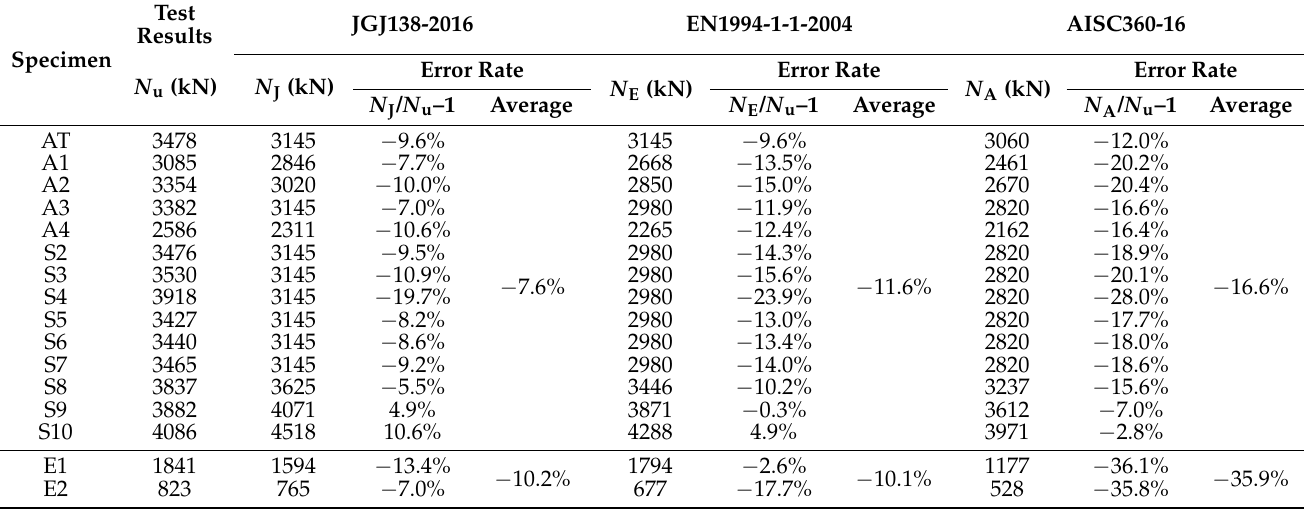
Figure 14. The simulation results at different stirrup strengths: ( a ) the ductility coefficient at differ- ent stirrup strengths; ( b ) the N – Δ curves at different stirrup strengths; ( c ) the rebar stress nephogram of specimen S7.